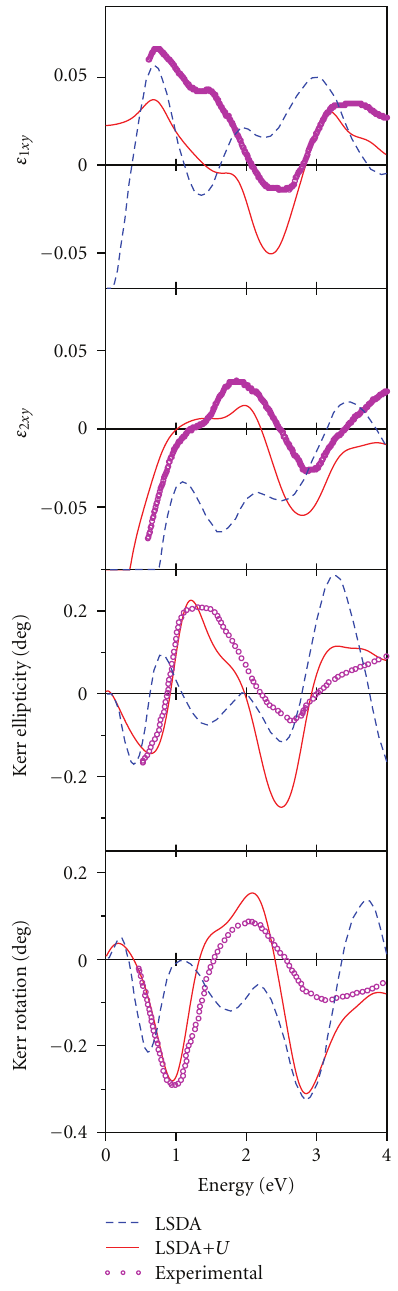
Figure 7: Calculated Kerr rotation and Kerr ellipticity spectra of Fe 3 O 4 [10] compared with experimental data (circles)